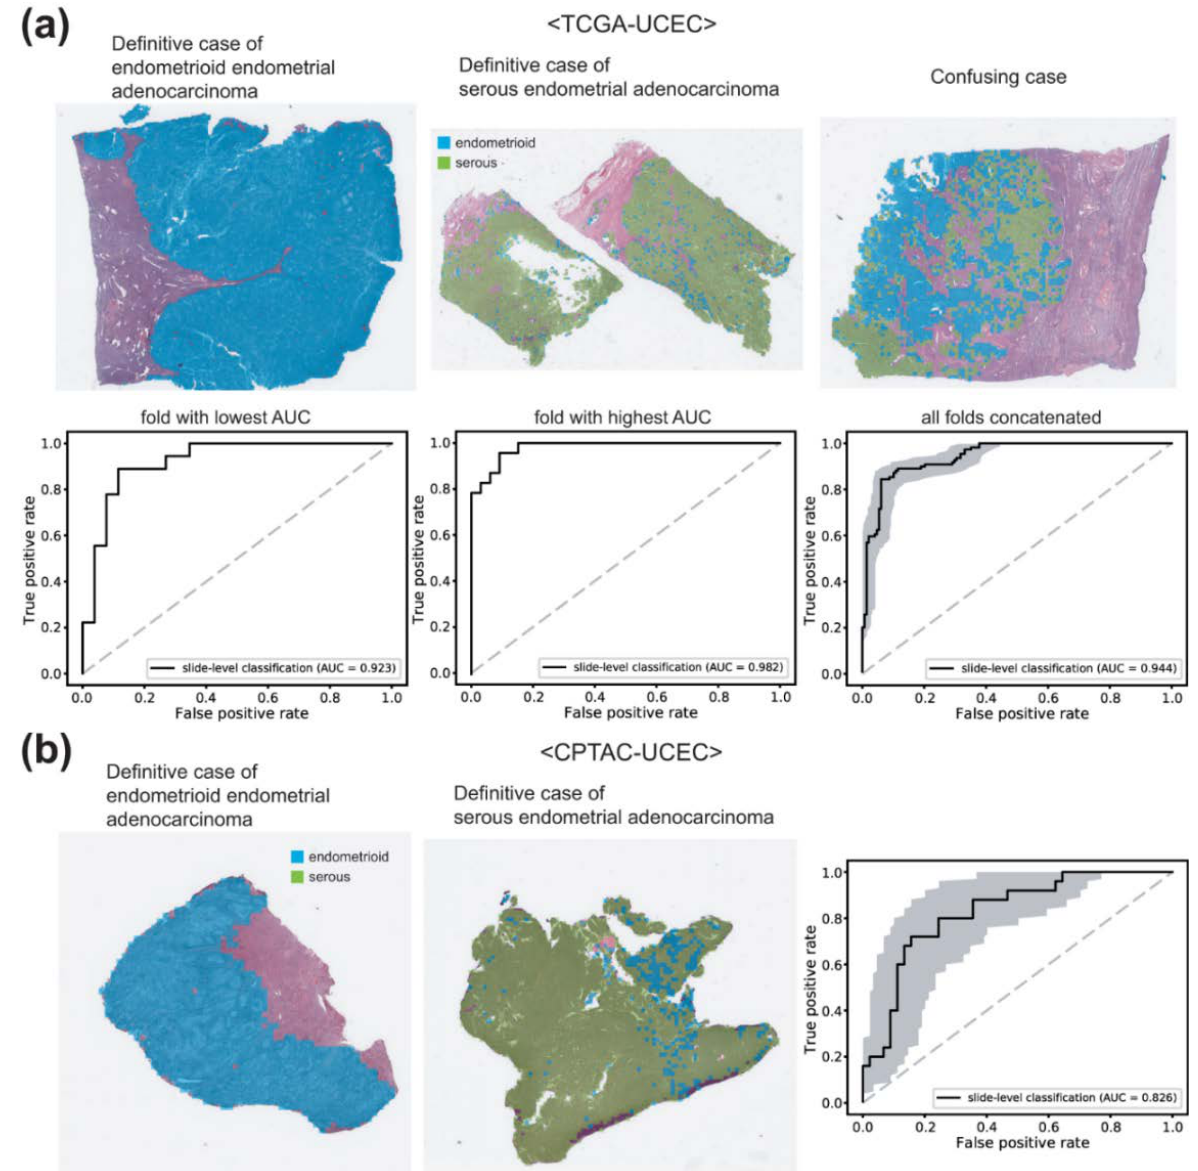
Figure 4. Classification results for endometrial cancer subtypes. ( a ) Results for the TCGA-UCEC dataset. Upper panels: the representative whole slide images (WSIs) of clear endometrioid endome- trial adenocarcinoma, clear serous endometrial adenocarcinoma, and confusing case with mixed classification results. Lower panels: the receiver operating characteristic (ROC) curves of slide-level classification results for folds with the lowest and highest area under the curve (AUC) and con- catenated results of all 5-folds. ( b ) The classification results of the CPTAC-UCEC dataset by the classifier trained with the TCGA-UCEC dataset. Left two representative WSIs demonstrate clear endometrioid endometrial adenocarcinoma and clear serous endometrial adenocarcinoma. The ROC curve is obtained from all CPTAC-UCEC tissues with more than 30% of tumor tissue regions.